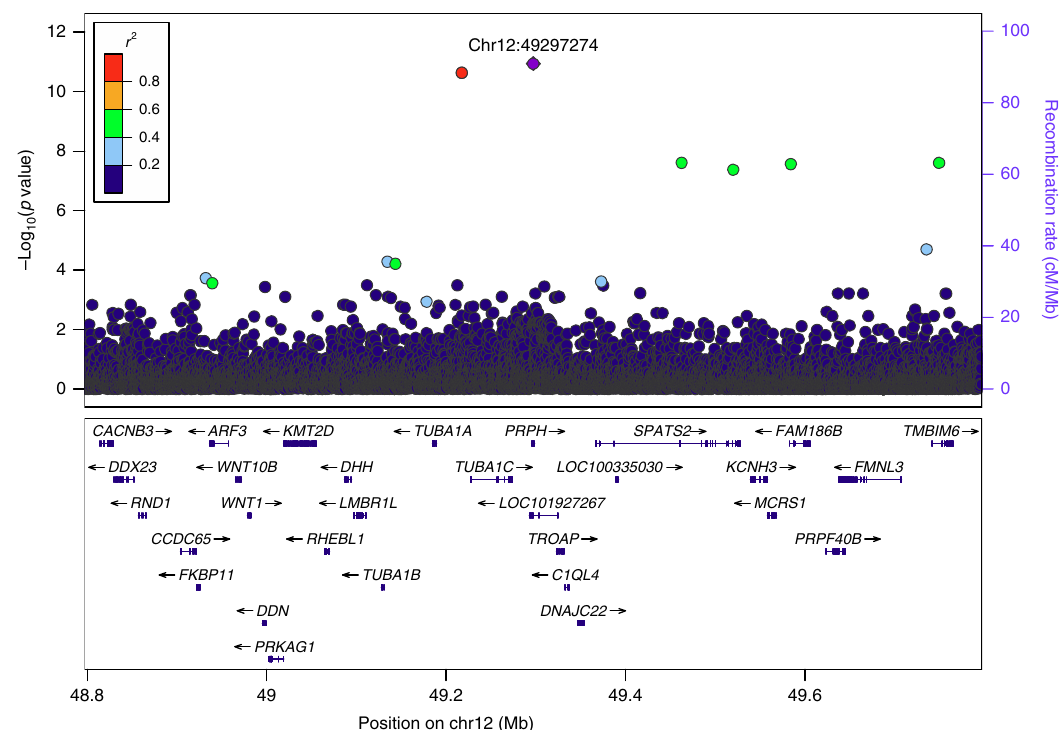
Fig. 1 Regional association plot for the PRPH splice-donor variant association with SNAP. P values ( − log 10 ) of single-nucleotide polymorphism (SNP) associations with SNAP ( N = 6879) are plotted against their positions at the 12q13.12 locus. SNPs are colored to re fl ect their linkage disequilibrium (LD) with rs73112142 (chr12:49297274, purple diamond) in the dataset. The only other marker in the vicinity is an intergenic, highly correlated variant rs532888409 ( r 2 = 0.93, D ′ = 0.97). The right y -axis shows calculated recombination rates at the chromosomal location, plotted as solid gray lines (none in the shown region). Known genes in the region are shown underneath the plot, taken from the UCSC genes track in the UCSC Genome Browser (URLs). All positions are in NCBI Build 38 coordinates. A chi-squared test was used to calculate P values. Source data are provided in a Source Data fi le